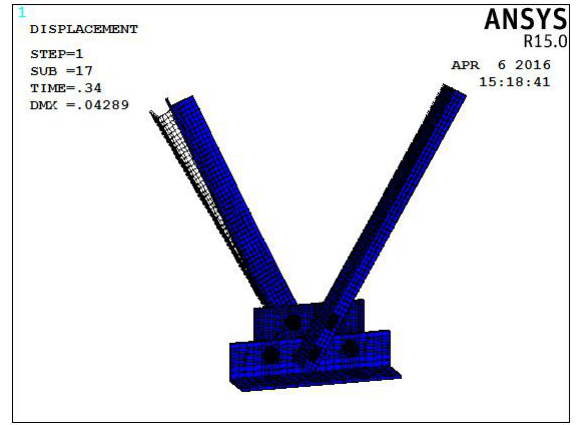
Figure 6: Overall deformed shape of joint model